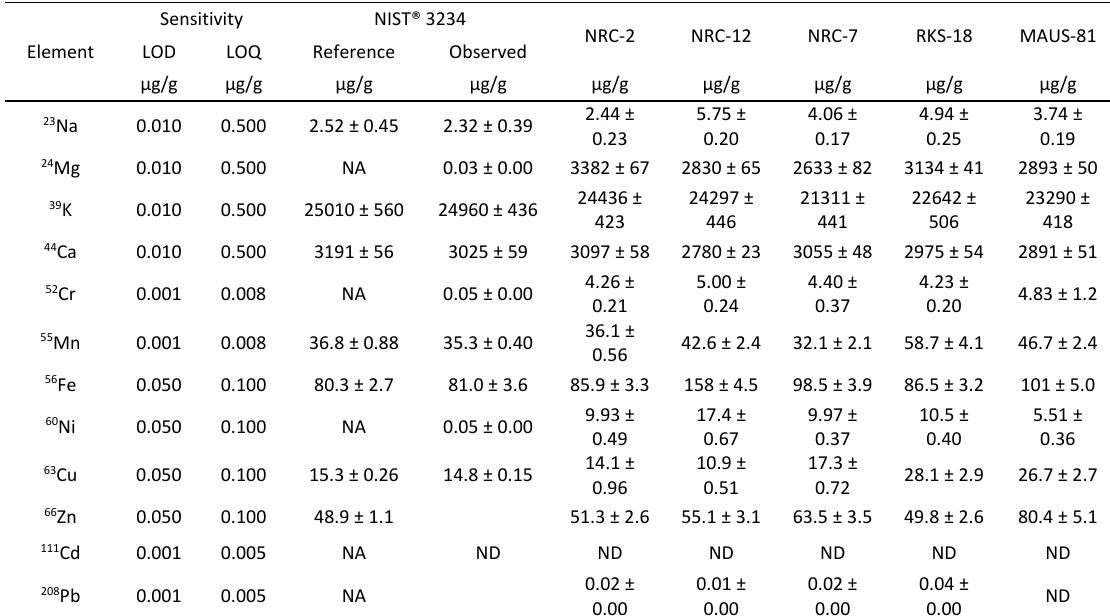
Table 4: Elemental analysis of NIST®3234 soybean flour and soybean varieties Ahilya 1 (NRC‐2), Ahilya 2 (NRC‐12), Ahilya 3 (NRC‐7), Pratap soya (RKS‐18), and Shakti (MAUS‐81) using ICP‐MS